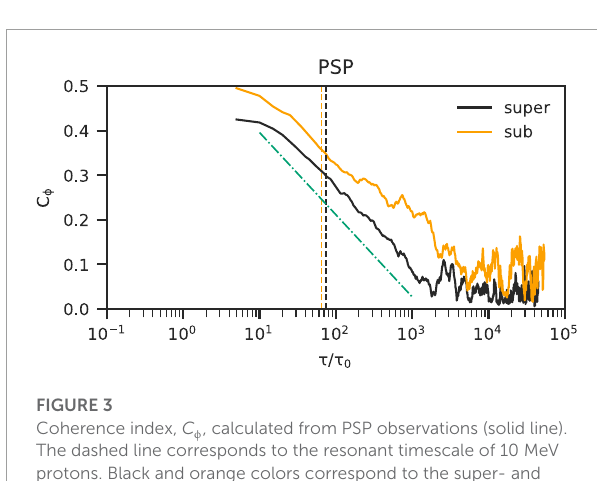
FIGURE 2 Coherence index, C ϕ , calculated from Helios 2 observations (solid line). The dashed line corresponds to the resonant timescale of 10 MeV protons. Black, orange, and blue colors correspond to distances at 0.87, 0.65, and 0.29 au, respectively. The green dashed-dotted line is proportional to log [( τ / τ 0 ) 0 . 1 ] . Here, τ 0 is the local proton gyro period calculated at each distance.